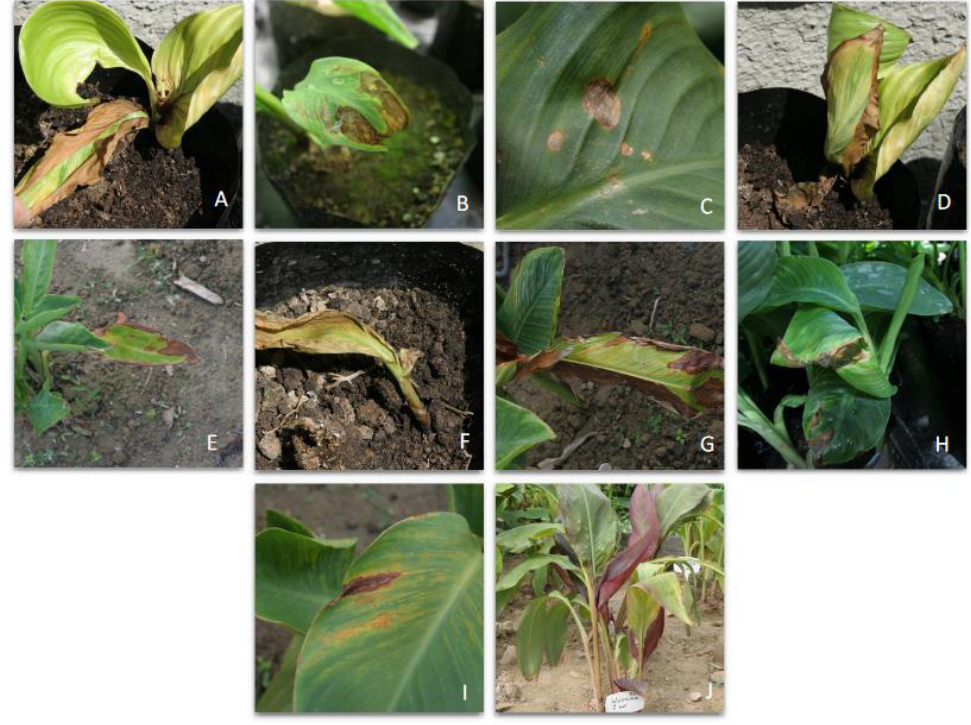
Figure 5. Disease symptoms on leaves of different canna varieties: ( A )—‘Aida’, ( B )—‘America’, ( C )—‘Botanica’, ( D )—‘Cherry Red’, ( E )—‘La Boheme’, ( F )—‘Lucifer’, ( G )—‘Picasso’, ( H )—‘President’, ( I )—‘Robert Kemp’, ( J )—‘Wyoming’.